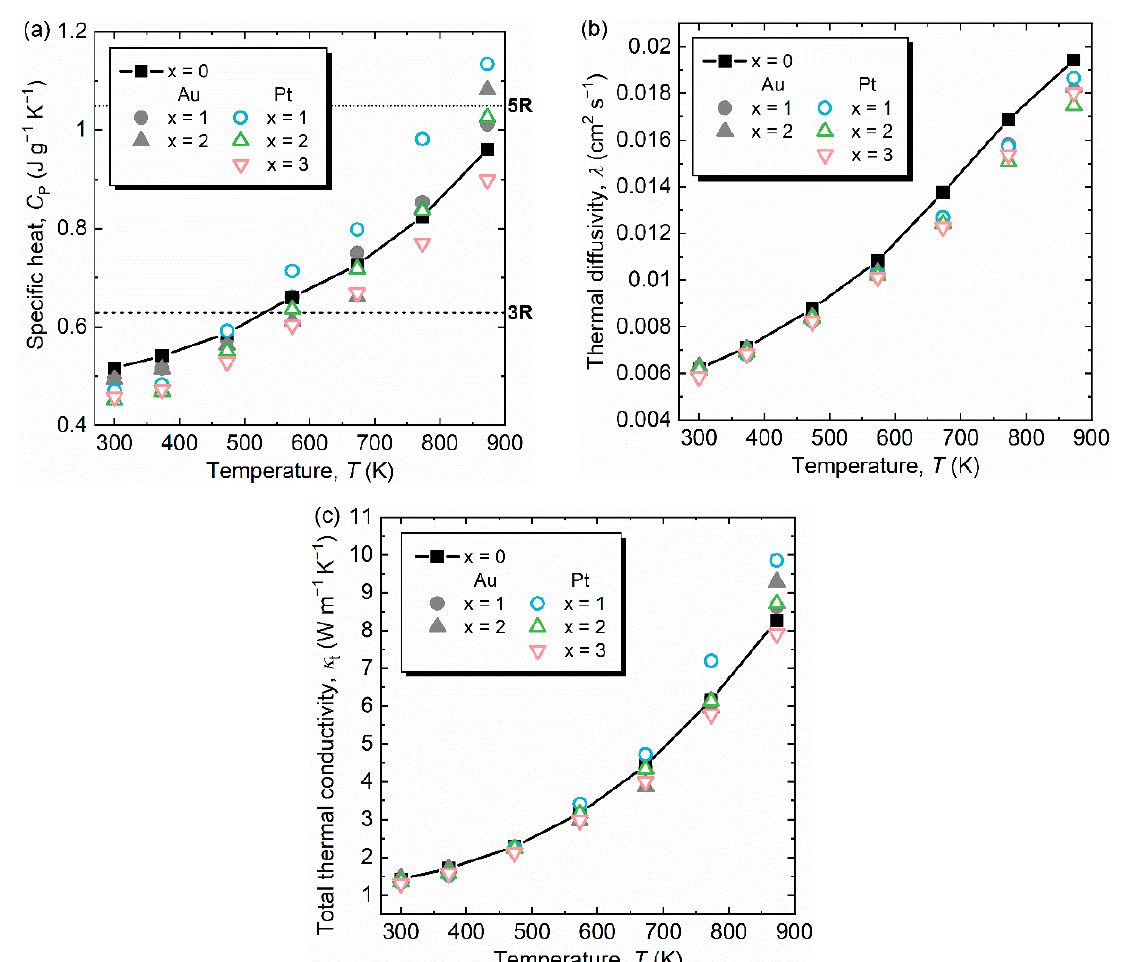
Figure 3. ( a ) Specific heat at constant pressure C P , ( b ) thermal diffusivity λ , and ( c ) total thermal conductivity κ t as a function of temperature for Al 63 Cu 25 − x (Au,Pt) x Fe 12 ( x = 0, 1, 2, 3). The dashed and dotted lines represent the Dulong–Petit limit (3 R ) and 5 R , respectively. Al 63 Cu 22 Au 3 Fe 12 is excluded because of secondary phase